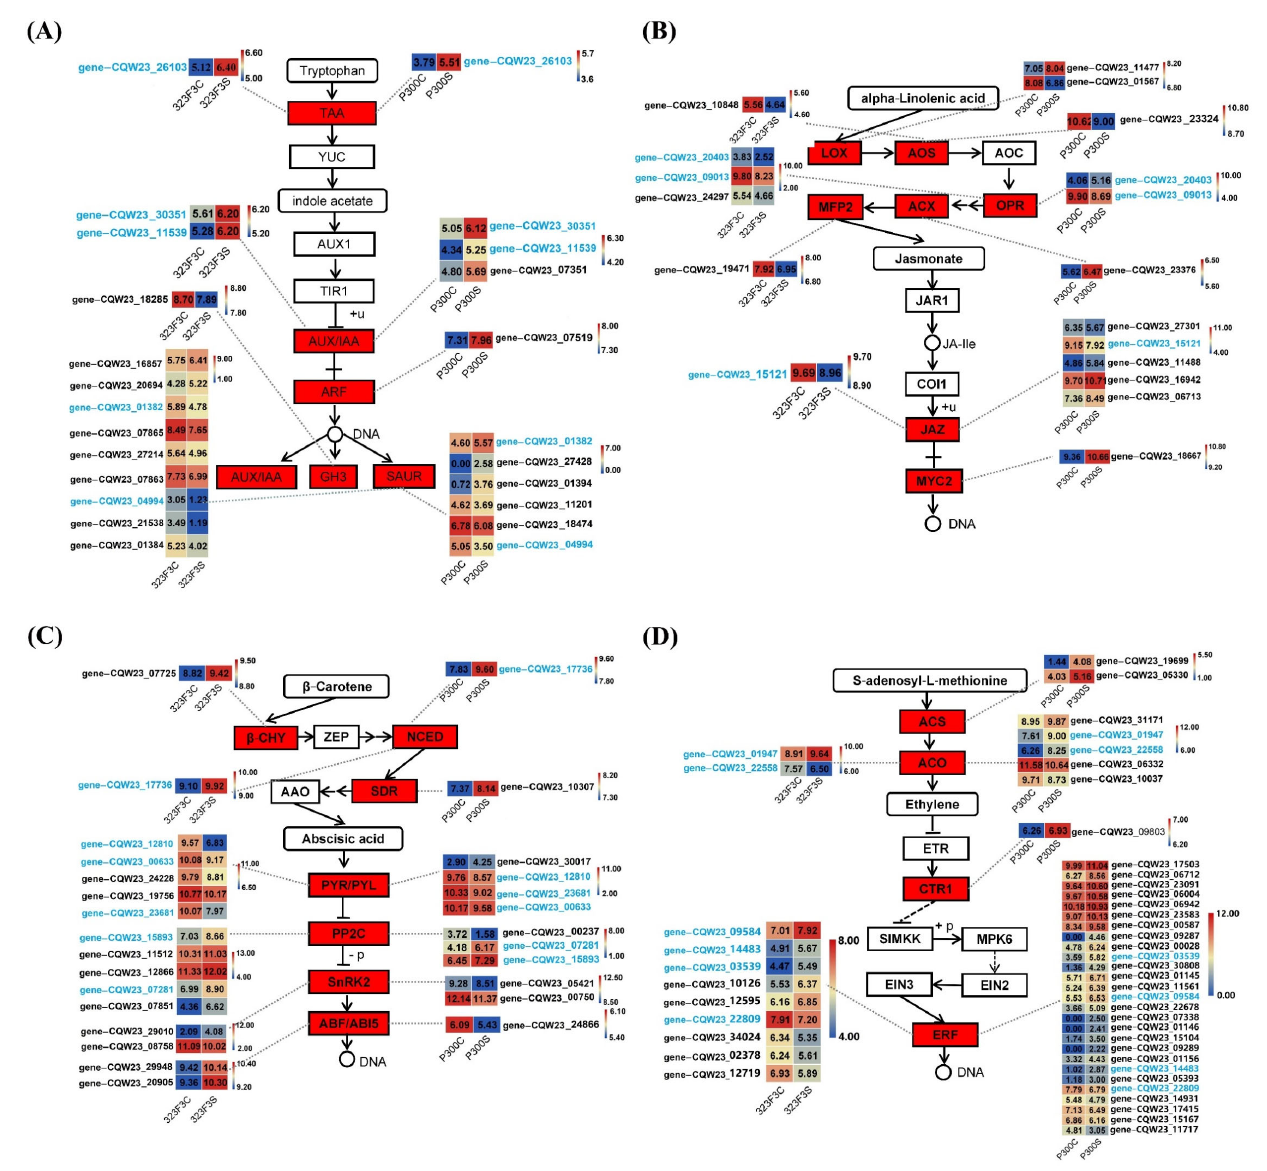
(Figure 9B, Table S2), only one relevant DEG ( gene–CQW23_15121 that encodes JAZ protein) was found to be down-regulated in 323F3C vs. 323F3S, which was also down-regulated in P300C vs. P300S. Another four JAZ genes were found to be specific DEGs in P300C vs. P300S, and three of them ( gene–CQW23_11488 , gene–CQW23_16942 and gene–CQW23_06713 ) were up-regulated. Moreover, one MYC2 gene ( gene–CQW23_18667 ) increased by 2.45-fold in P300 under salt stress. Briefly, all of the JA synthesis and signaling-related DEGs were down-regulated by salt in 323F3; meanwhile, in P300, several JA synthesis and signaling genes responded positively to salt stress.